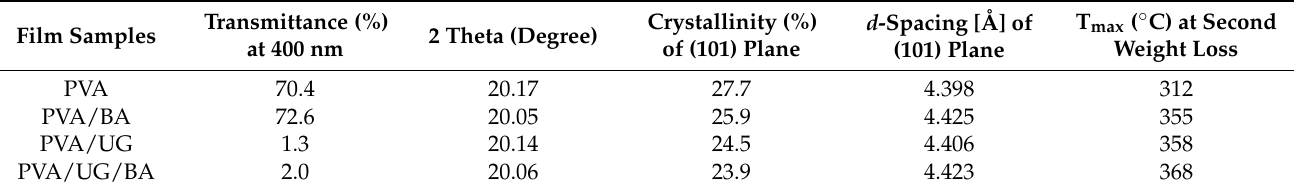
Figure 4. XRD pattern of PVA and the blend films. Table 1. Light transmittance from Figure 1b, CI from Figure 4, d -lattice plane spacing from X-ray diffraction data, and T max from Figure 5b.